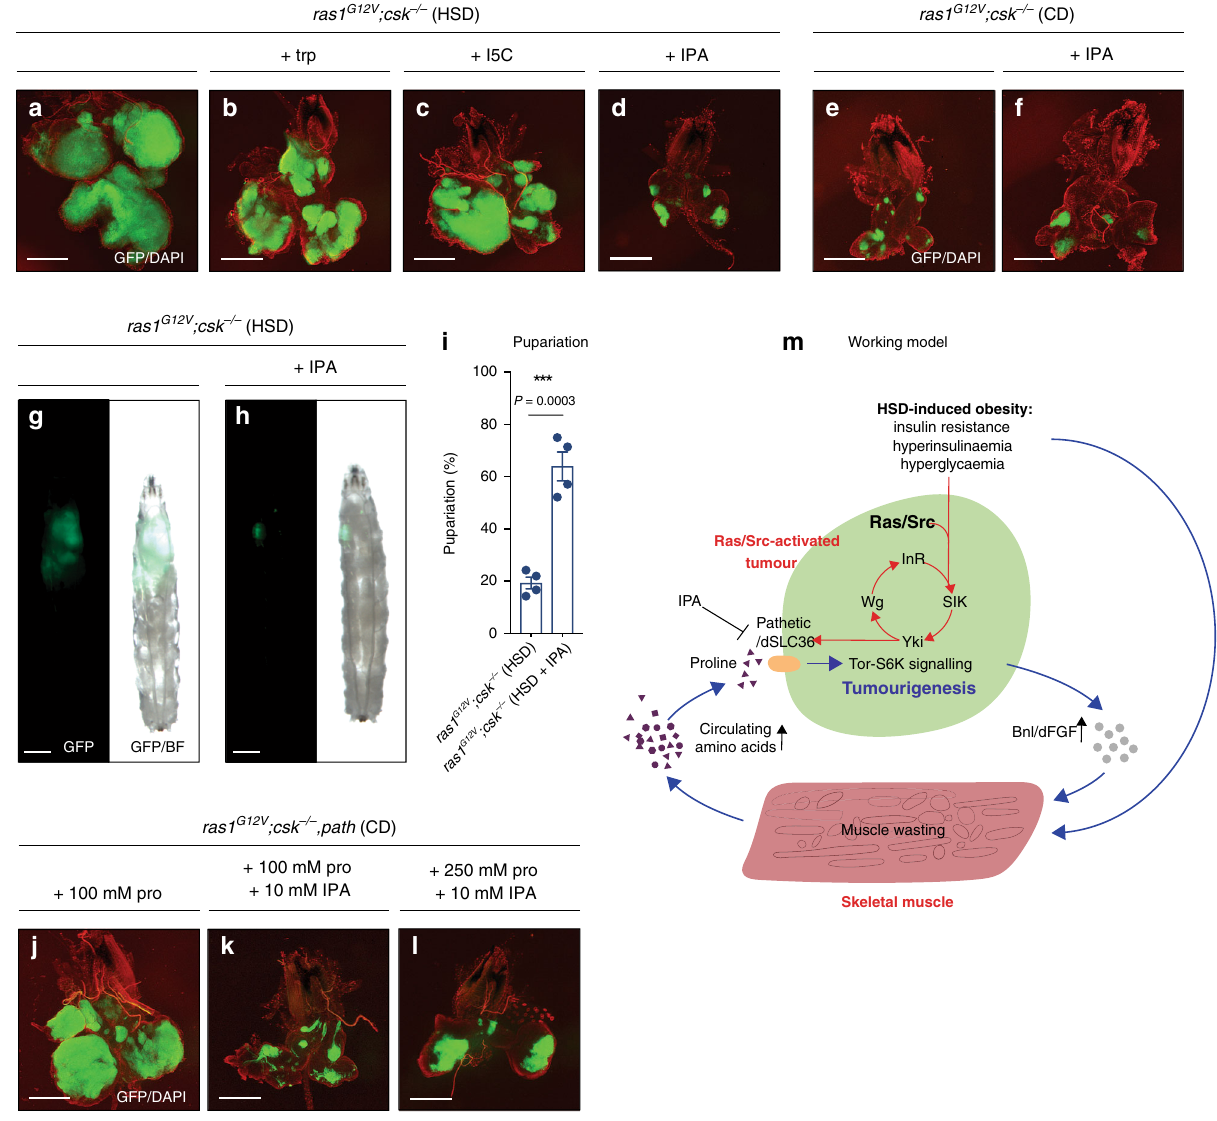
Fig. 6 Targeting SLC36-transporter with amino acid derivative suppresses tumour growth. Dissected eye epithelial tissue stained with DAPI (red) from ras1 G12V ;csk − / − animals raised on HSD ( a ), HSD supplemented with 10 mM L-tryptophan (trp) ( b ), HSD supplemented with 10 mM Indole-5-carboxylic acid (I5C) ( c ) and HSD supplemented with 10 mM Indole-3-propionic acid (IPA) ( d ). Scale bar, 250 μ m. Dissected eye epithelial tissue stained with DAPI (red) from ras1 G12V ;csk − / − animals raised on CD ( e ) and CD supplemented with 10 mM IPA ( f ). Scale bar, 250 μ m. Third-instar larvae from ras1 G12V ;csk − / − animals raised on HSD ( g ) and HSD supplemented with 10 mM IPA ( h ). Scale bar, 500 μ m. i Pupariation percentage of ras1 G12V ;csk − / − animals raised on HSD and HSD supplemented with 10 mM IPA. Results are shown as mean ± SEM. Data from total n = 120 (HSD) and n = 75 (HSD + IPA) from four independent experiments. Data were analysed by two-tailed unpaired Student ’ s t test. Asterisks indicate statistically signi fi cant difference (*** P < 0.001). Dissected eye epithelial tissue stained with DAPI (red) from ras1 G12V ;csk − / − ,path animals raised on CD supplemented with 100 mM L-proline ( j ), CD supplemented with 100 mM L-proline and 10 mM IPA ( k ) and CD supplemented with 250 mM L-proline and 10 mM IPA ( l ). Scale bar, 250 μ m. m Working model illustrating dual-layered coordination of tumour metabolic response: (1) at the whole organism level — branchless (Bnl)-dependent induction of cachexia-like muscle wasting and systemic amino acid release (blue arrows) — and (2) at the tumour-autonomous level — Yorkie-dependent induction of amino acid transporter expression (red arrows). The tumour-autonomous SIK-Yki-Wg-InR circuit was identi fi ed previously 14 . IPA represents a therapeutic strategy to break the nutritional circuit between muscle wasting and tumour growth by targeting the SLC36-family transporter Path. SIK Salt-inducible kinase, Yki Yorkie, Wg wingless, InR insulin receptor, IPA indole-3-propionic